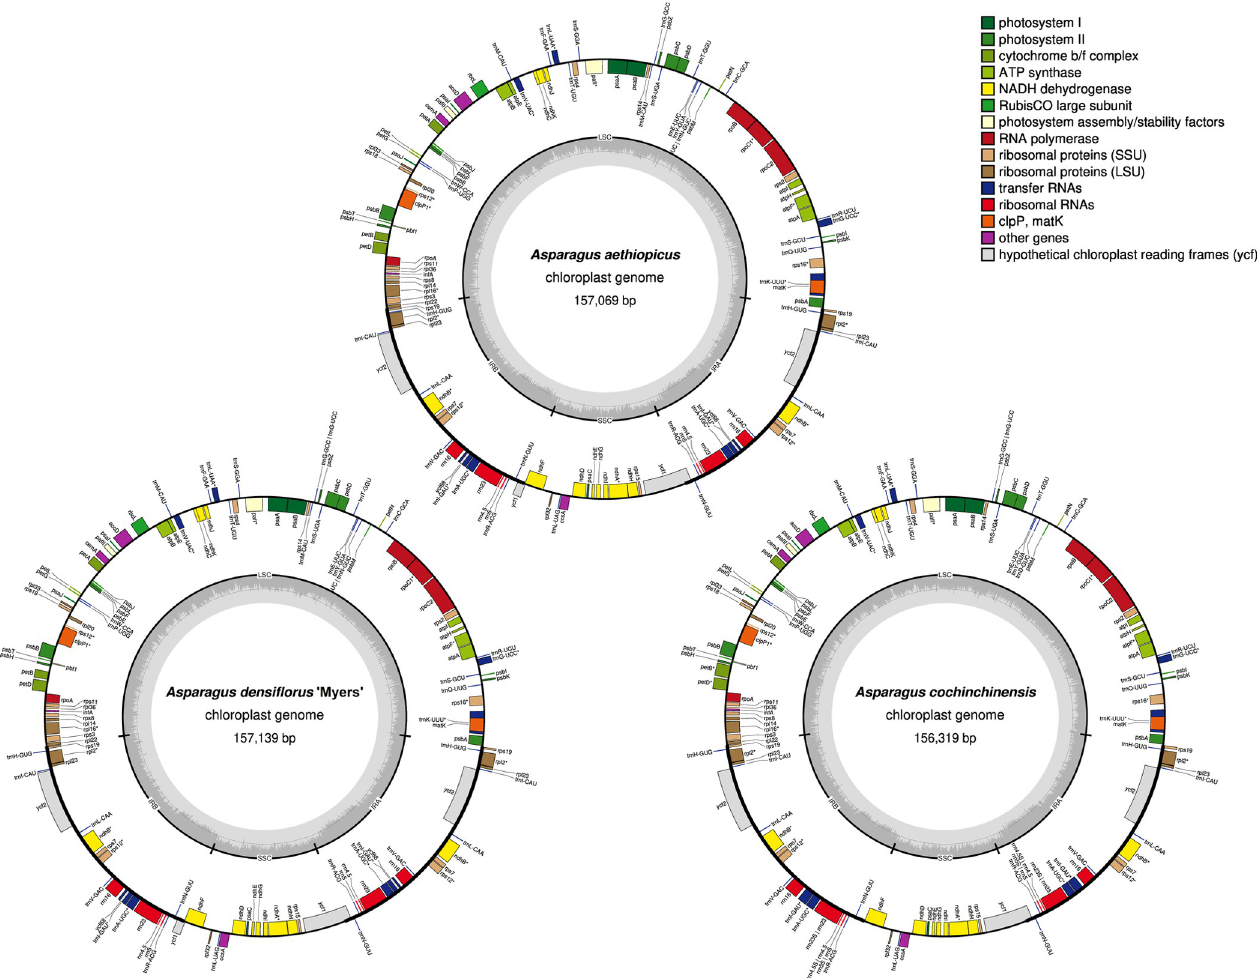
Fig 2. Chloroplast genome map of A . aethiopicus L., A . densiflorus (Kunth) Jessop ‘Myers’, and A . cochinchinensis (Lour.) Merr. Genes are colour-coded based on their functions shown in the key. Genes located outside of the outer circle are transcribed anticlockwise, while those inside are transcribed clockwise. In the inner circle, the gradient in dark grey represents GC content, whereas light grey represents AT